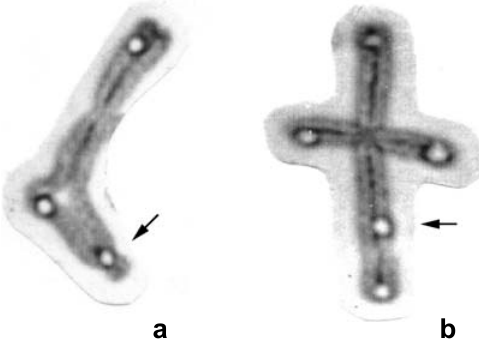
Figure 3 - a and b , Trirradial and quadriradial aberrant CHO chromosomes showing holes induced in subtelomeric and paracentric areas